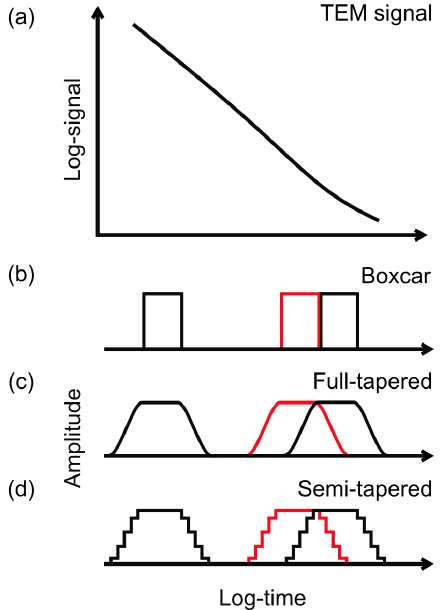
Figure 1. The plot in (a) illustrates a decaying TEM signal. The plots in (b) – (d) show the rectangular, full-tapered, and semi-tapered gates, respectively. For simplicity only three gates are shown for each gating strategy, and they are colored to make them distinguish- able. Both full-tapered and semi-tapered gates overlap with neigh- boring gates. The gate widths are exponentially increasing; hence gates appear with identical widths on the logarithmic time axis.